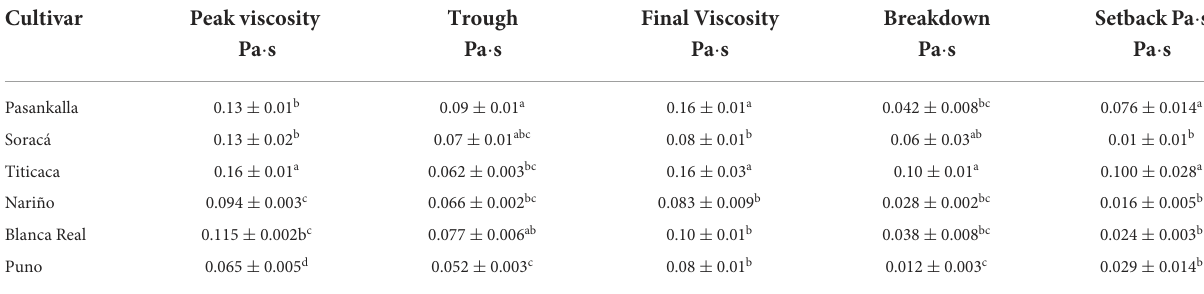
TABLE 1 Pasting properties of quinoa dispersions.